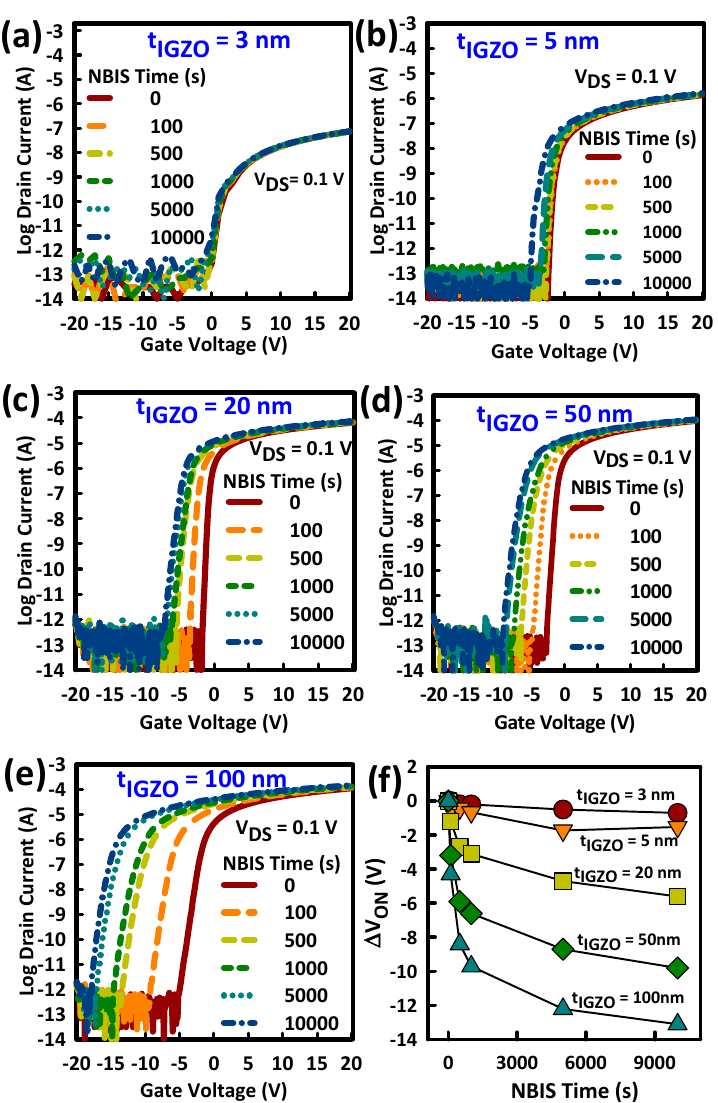
Figure 5. Effect of negative-gate bias stress combined with visible light illumination (NBIS). ( a – e ) thin-film transistor (TFT) current-voltage ( I - V ) characteristics before and after NBIS for varying amorphous indium-gallium zinc-oxide thickness ( t IGZO ). ( f ) Turn-on voltage ( V ON ) dependence on NBIS Time. Channel width W = 2000 µm and channel length L = 10 µm. The NBIS-induced negative turn-on voltage ( V ON ) shift increases with increasing t IGZO . NBIS is accomplished by holding the TFT gate voltage at − 20 V for 10,000 s, while biasing the source and drain electrodes at zero volts, under white light illumination (9000 nit).